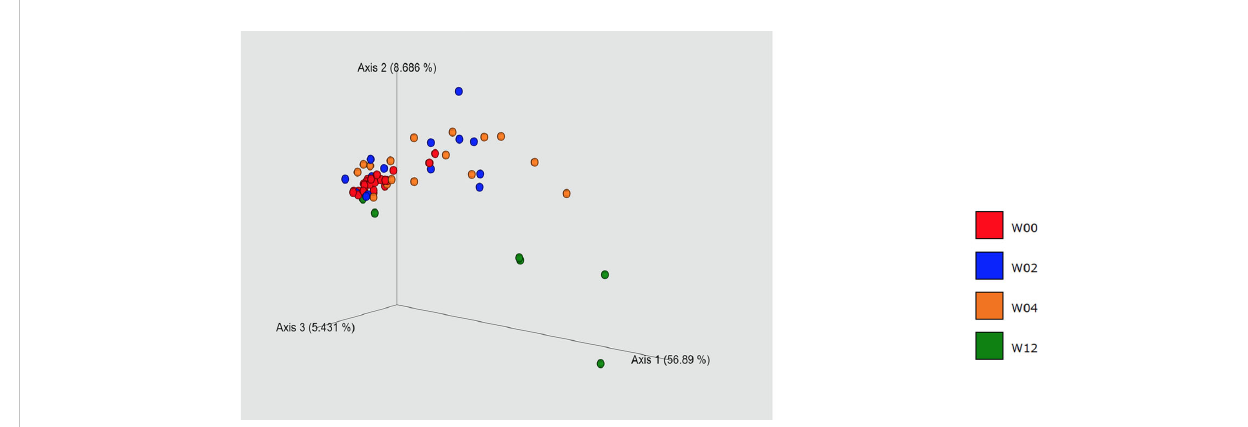
FIGURE 1 Principal coordinate analysis. W00, W02, W04, and W12 represent before operation and 2-, 4-, and 12 -weeks after operation, respectively. Some of the W12 specimens showed a composition close to that of the preoperative one, while the others showed a considerable